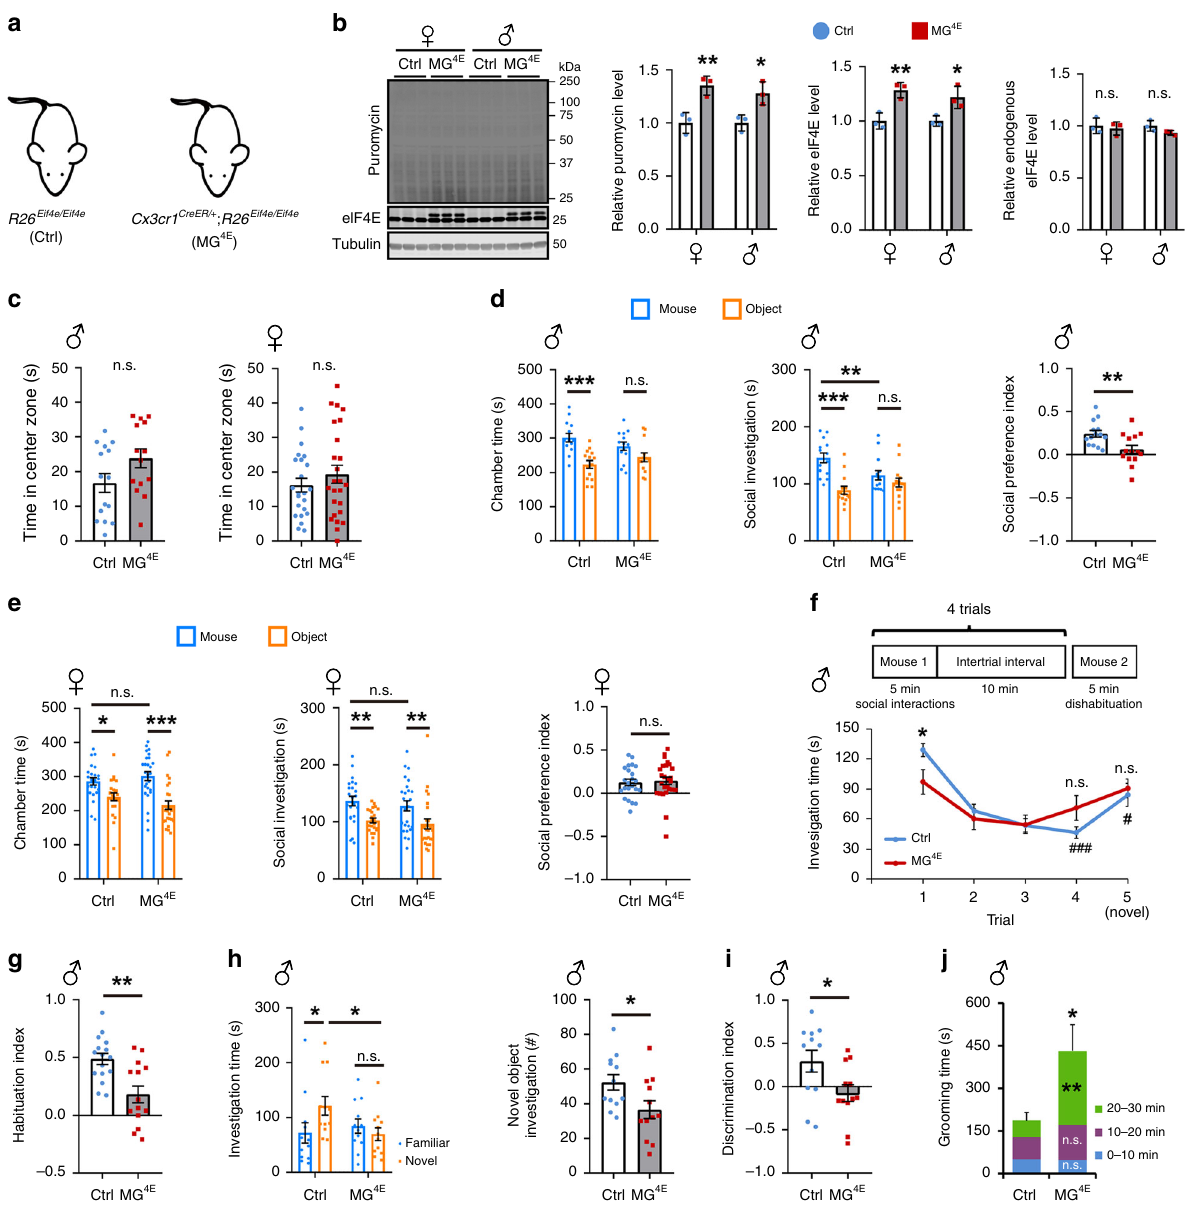
Fig. 2 Overexpression of eIF4E in microglia leads to social de fi cits. a Genotypes of control (Ctrl) and MG 4E mice. b Microglial eIF4E overexpression and protein synthesis in cultured microglia isolated from both sexes of control and MG 4E mice. n = 3 per condition. Two-sided t -test: puromycin, female ** p = 0.0099 and male * p = 0.0217; eIF4E, female ** p = 0.0088 and male * p = 0.0293. c Time spent in the central zone during the fi rst 5 min of open fi eld tests. Male: 15 control mice and 14 MG 4E mice; Female: 23 control mice and 25 MG 4E mice. n.s. not signi fi cant by two-sided t -test. d , e Sociability of MG 4E mice. Male: 14 control mice and 14 MG 4E mice; Female: 23 control mice and 25 MG 4E mice. Two-way ANOVA with Fisher ’ s LSD post-hoc test for chamber time and social investigation: * p < 0.05; ** p < 0.01; *** p < 0.001; n.s. not signi fi cant. Two-sided t -test for social preference index: male, ** p = 0.0067; female, p = 0.7440. f Social habituation test. n = 16 male control and 14 male MG 4E mice. Two-way ANOVA with Fisher ’ s LSD post-hoc test: * p = 0.0159 between control and MG 4E mice in trial 1; ### p < 0.001 between trial1 and trial4 in control mice; # p = 0.0334 between trial 4 and trial 5 in control mice; n.s. not signi fi cant for comparisons of trial 1 vs. trial 4 and trial 4 vs. novel in MG 4E mice. g Habituation index. * * p = 0.0013 by two-sided t -test. h , i Novel object recognition. n = 12 control mice and 12 MG 4E mice. Two-way ANOVA with Fisher ’ s LSD post-hoc test: * p < 0.05 and n.s. not signi fi cant ( h ). Two-sided t - test: * p = 0.0297 ( i ). j , Self-grooming. The 30-min self-grooming test was divided into three 10-min segments. n = 6 mice per genotype. Two-way ANOVA with Fisher ’ s LSD post-hoc test was used for each 10-min segment, whereas two-sided t -test was used for the whole 30-min test period. * p = 0.0276; ** p = 0.0016; n.s. not signi fi cant. Source data are provided as a Source Data fi